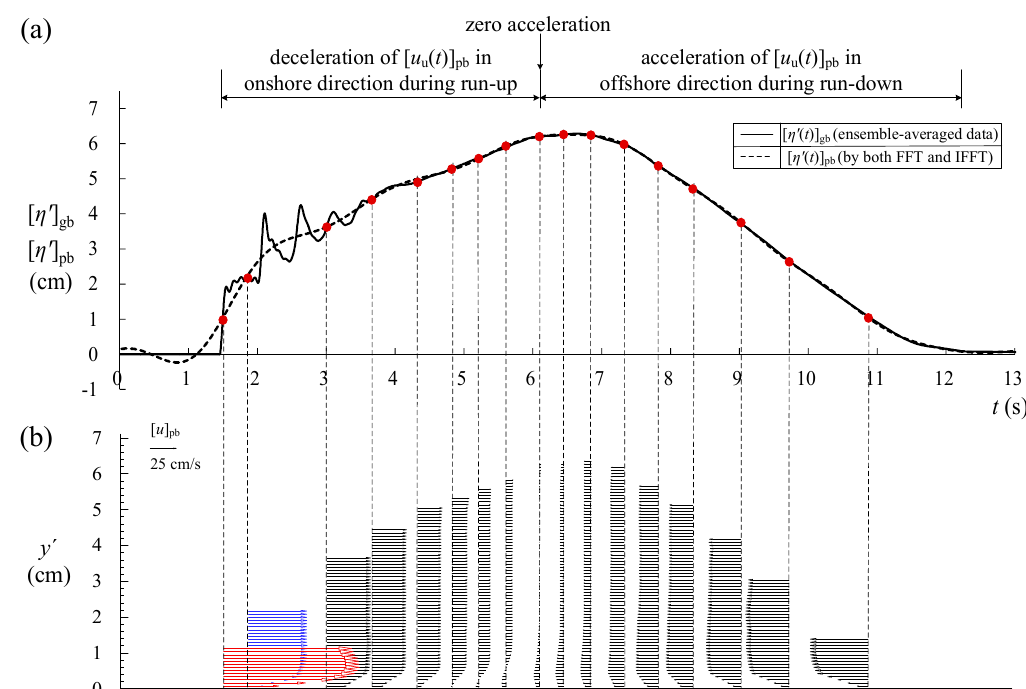
Figure 13. Temporal variations of ( a ) [ η ′ ( t )] gb and [ η ′ ( t )] pb ; ( b ) horizontal velocity profiles of pure bore throughout instantaneous water depths during run-up and run-down at SMS.